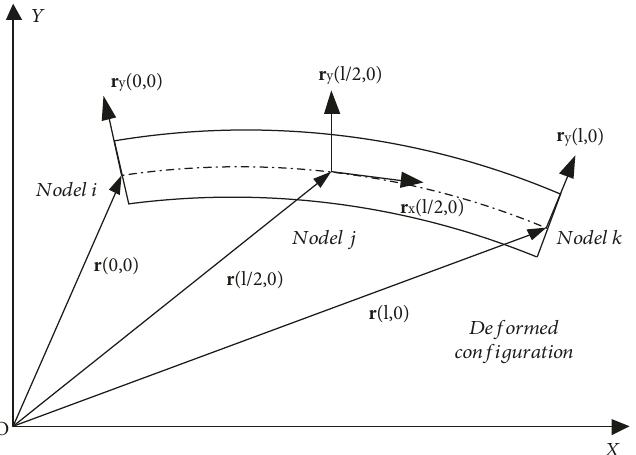
Figure 1: The position vector of an arbitrary point on the beam